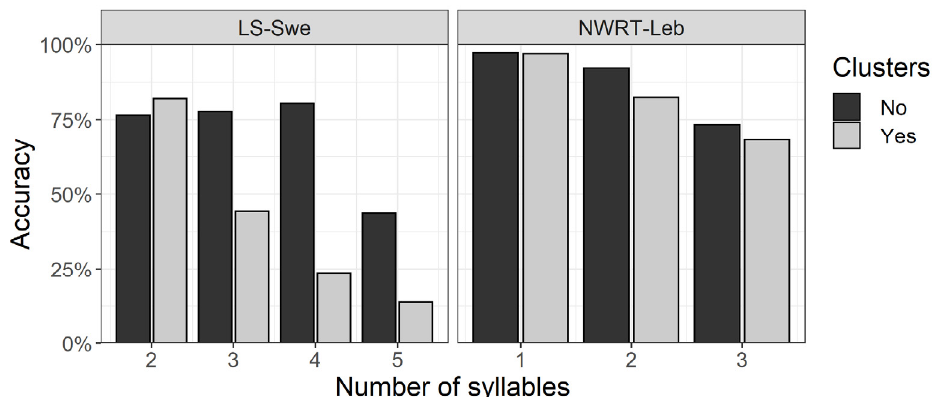
16 of 34 Figure 1. Accuracy (% correct responses), LS-Swe, CL-Swe and NWRT-Leb by number of syllables. As presented in Table 7, accuracy was generally highest for items with fewer syllables and without consonant clusters. In other words, accuracy decreased as a function of in- creasing number of syllables and the presence of consonant clusters. However, the accu- racy patterns for items with vs. without clusters were not the same for the LS-Swe task and the NWRT-Leb. In the NWRT-Leb, accuracy decreased by similar amounts for items with and without clusters as the number of syllables increased. By contrast, for the LS- Swe task, accuracy levels were similar for 2–4-syllable items without clusters, but de- creased steeply at five syllables, whilst accuracy levels for the items with clusters de- creased for each added syllable. This difference is visualised in Figure 2. Potential inter- actions between item length and presence of clusters will be explored further in the mul- tivariate mixed-effects regression models. Table 7. Accuracy (% correct responses) by task and number of syllables for all items, items with clusters and items without ( w / o ) clusters. LS-Swe CL-Swe